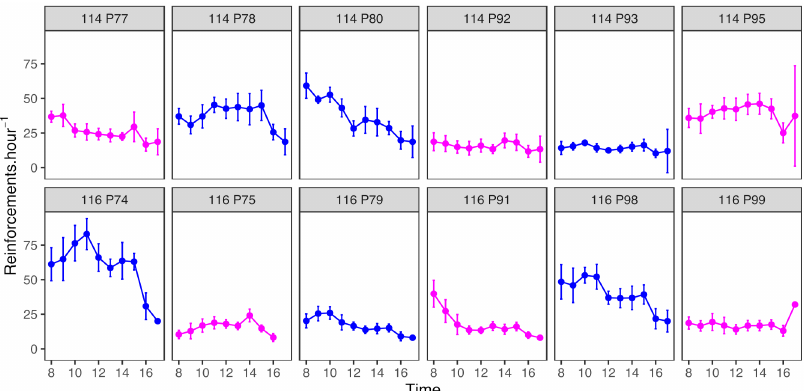
Figure 5. Rate of earning reinforcements declines over the day. Panels show scatterplots of the average reinforcement rate (mean ± 95% CI) by time of day for each of the 12 birds. Each row of panels corresponds to one experimental aviary. Data from male birds are shown in blue and females in